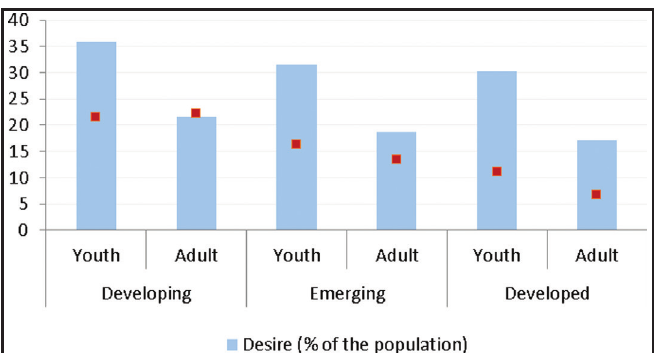
Figure 1 Average migration intention among youth (15–34) and adults